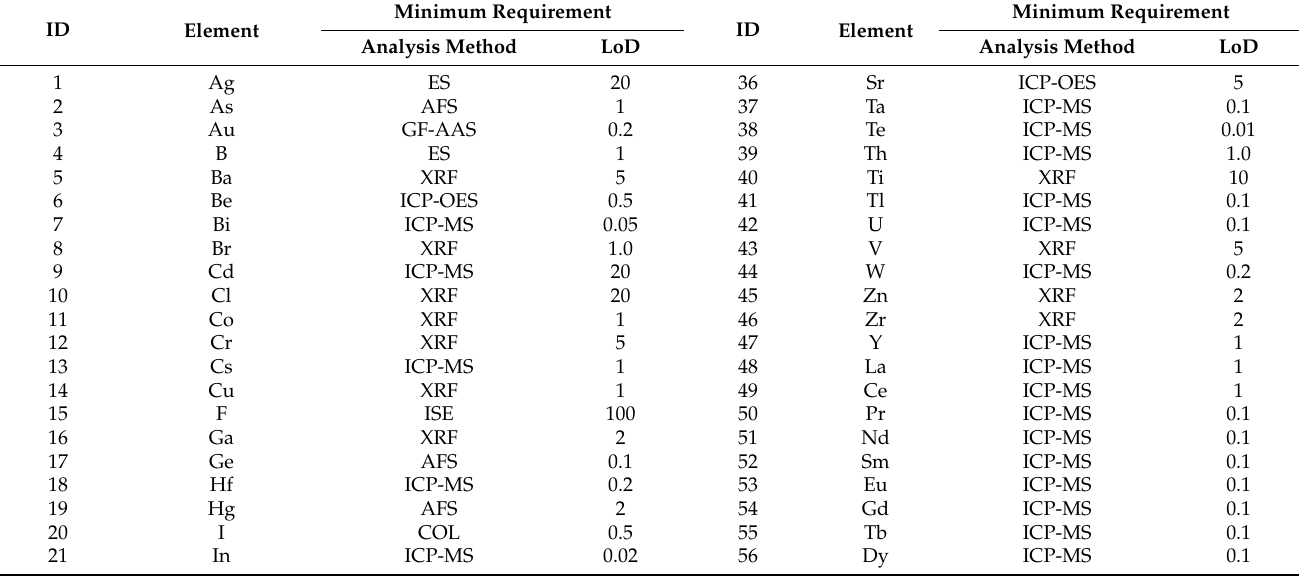
Table 2. Detection limits of the 69 elements. SiO 2 , Al 2 O 3 , Tot. Fe 2 O 3 , MgO, CaO, Na 2 O, K 2 O, and C are expressed in %; Ag, Au, Cd, and Hg are expressed in µ g/kg; other elements are expressed in mg/kg; LoD = limit of